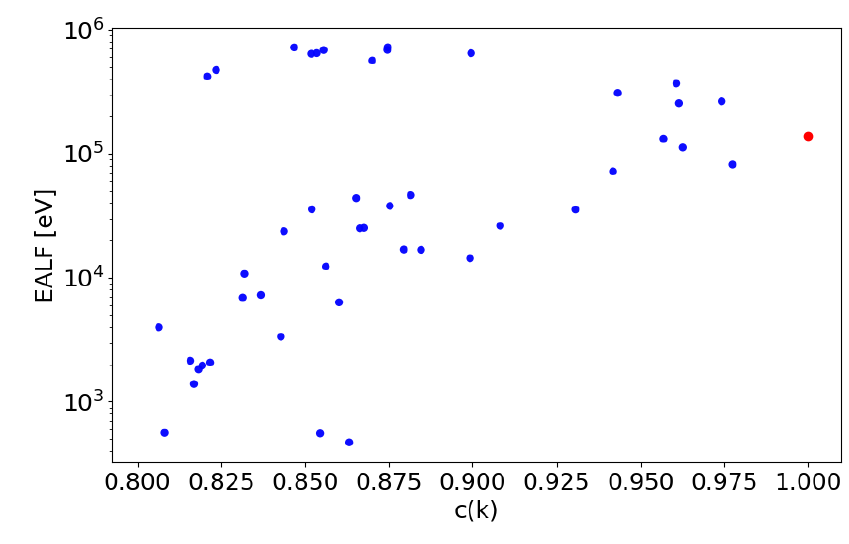
Figure 3a. EALF for the relevant experiments and Case 3.